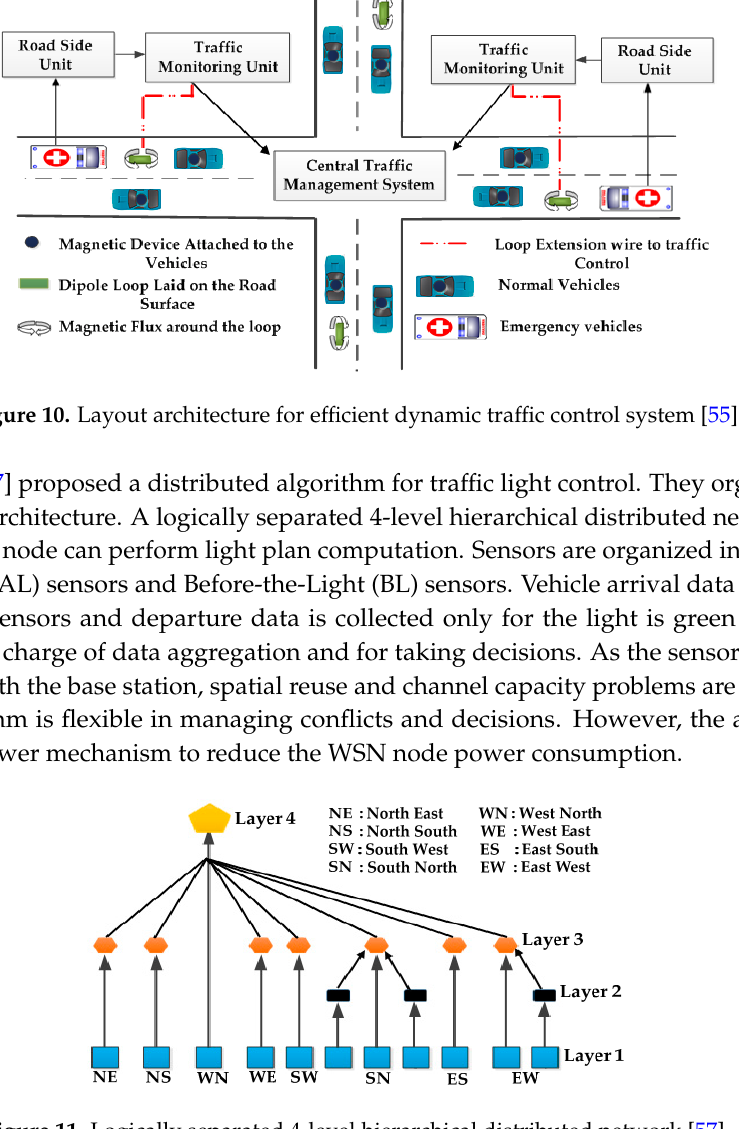
Figure 11. Logically separated 4-level hierarchical distributed network [57].